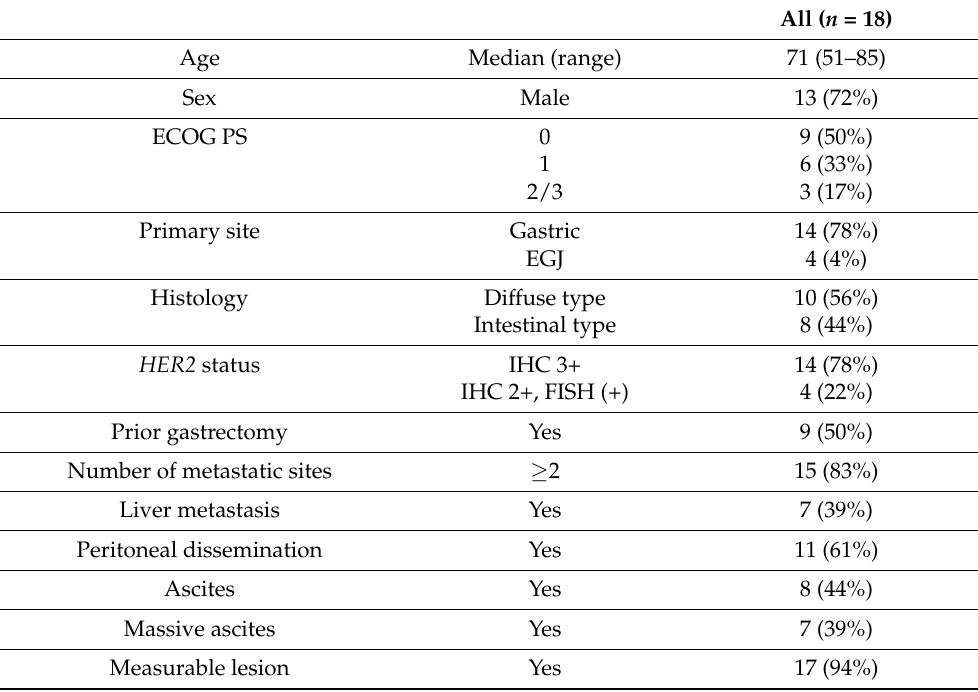
Table 1. Patients’ characteristics of this